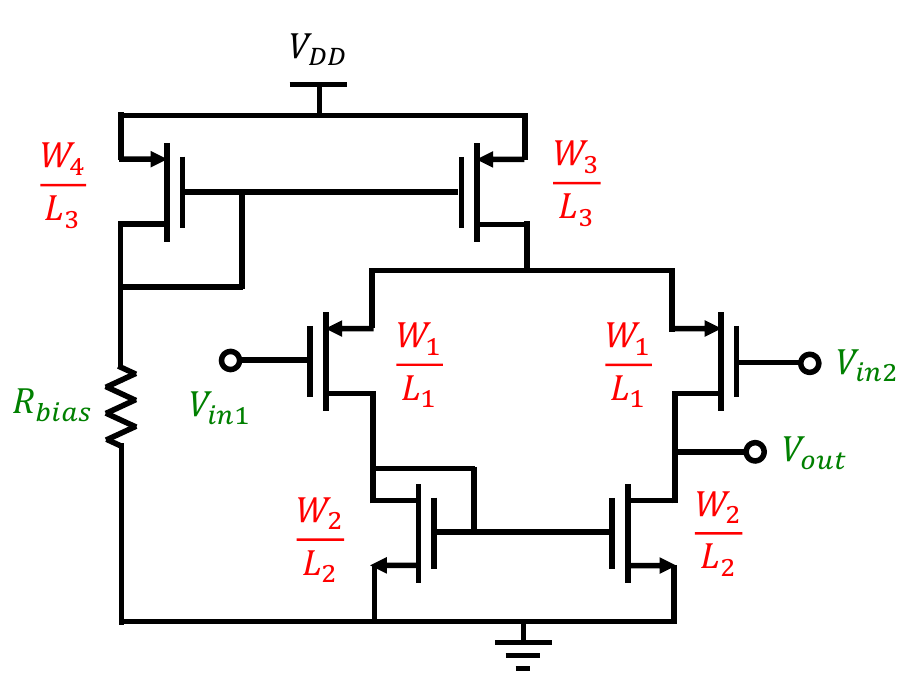
Figure 2. Simple CMOS differential pair amplifier with resistive biasing.